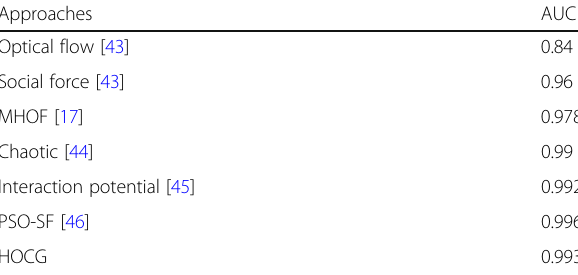
Table 4 Summary of the quantitative performance and a comparison with state-of-the-art approaches on the UMN